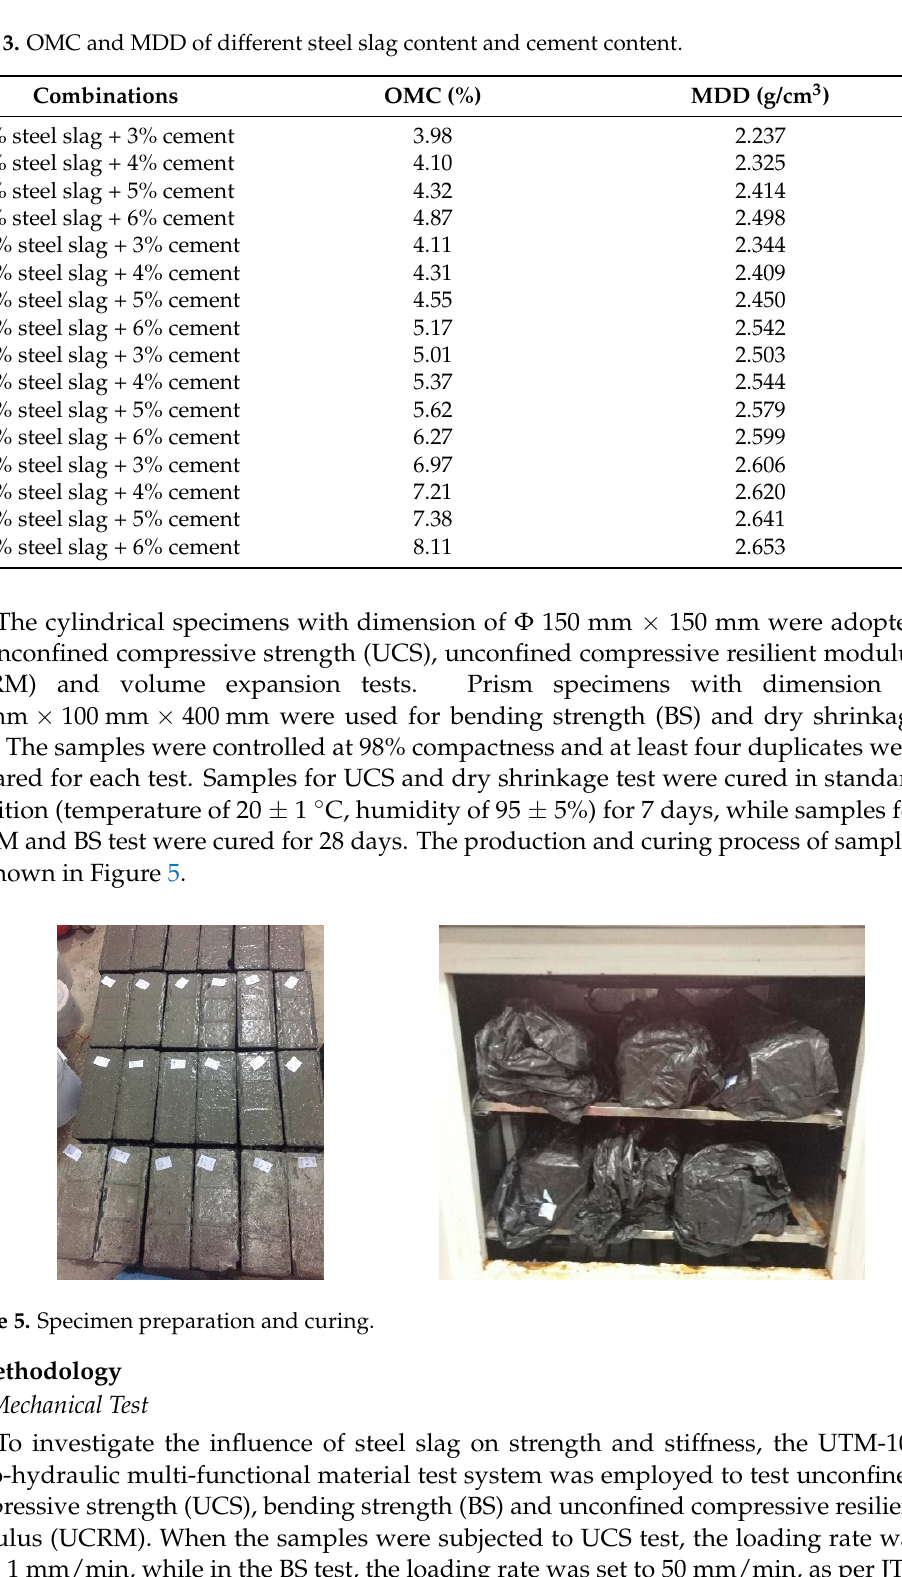
Figure 6. Mechanical properties test. 3.2. Volume Stability Test The volume stability test consists of two parts: the volume expansion of steel slag and the dry shrinkage of cement-stabilized aggregates containing steel slag. The safety of high- way is affected by the possible expansion caused by f-CaO and f-MgO in steel slag. Steel slag with no aging was compacted at OMC, and soaked in water in the mold with perme- able platters at each end. Dial directors were set to monitor the volume increase for 10 consecutive days. Samples treated with CH 3 COOH or silica fume were also tested to clar- ify their inhibition effect on volume expansion. To explore the shrinkage of mixture with different steel slag contents, after curing in standard condition for 7 days, prism samples were examined for initial mass and length and then set in a condition of 20 ± 1 °C and 60 ± 5 % humidity with both ends measured with dial directors to monitor the length change due to dry shrinkage. The mass and length of samples were recorded every day during the first 7 days, every other day from 7th to 28th day, and on the 60th and 90th day. In the end, the specimens were heated to constant weight. Length and mass of the final state were measured. The volume expansion of steel slag and dry shrinkage of cement concrete with steel slag are in Figure 7.